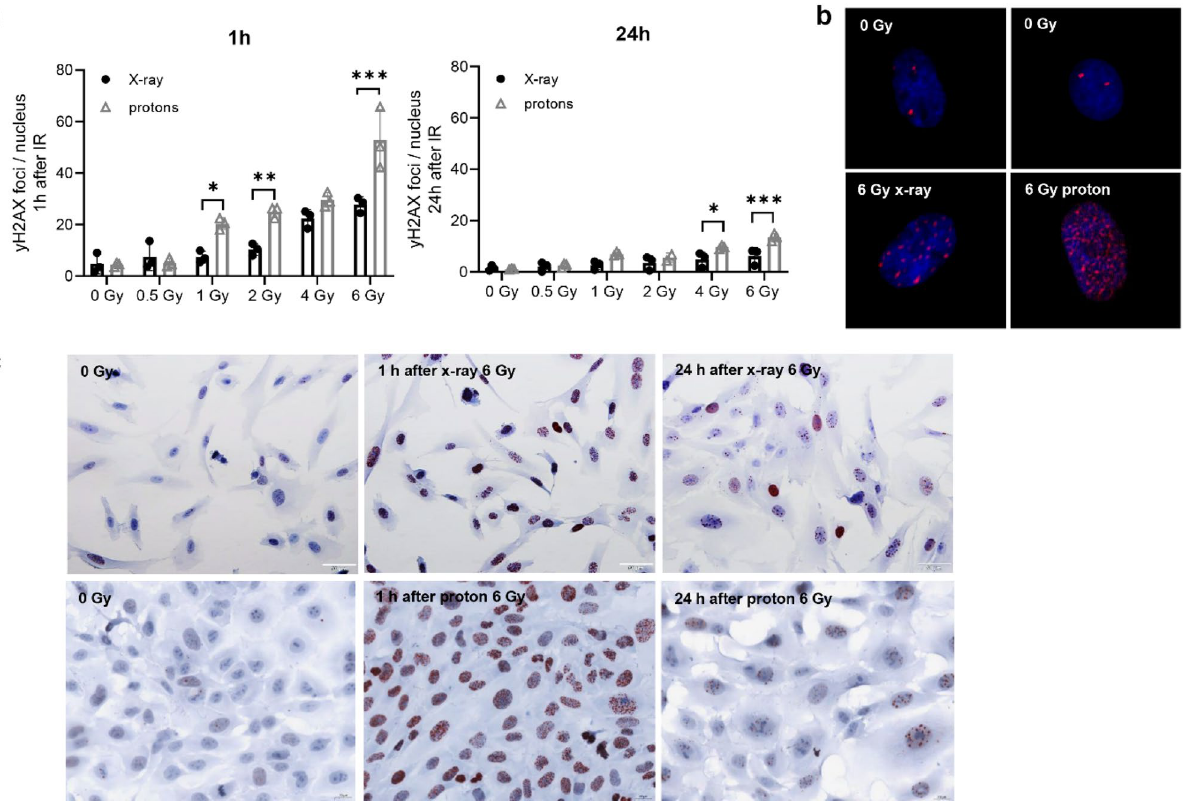
Figure 3. Detection of the DNA damage marker γH2AX. Chondrosarcoma cells were irradiated with 0.5, 1, 2, 4, and 6 Gy photon (X-ray) respectively proton ion particles and analysed using immunofluorescence and immunohistochemical stainings. ( a ) The statistical evaluation over the course of the IR dose. ( b ) Representative pictures of stained γH2AX foci in a single nucleus. ( c ) Immunohistochemical staining of γH2AX 1 h and 24 h after IR (n = 3; × 40 magnification). The significant increase of γH2AX observed after 1 h is hardly observed after 24